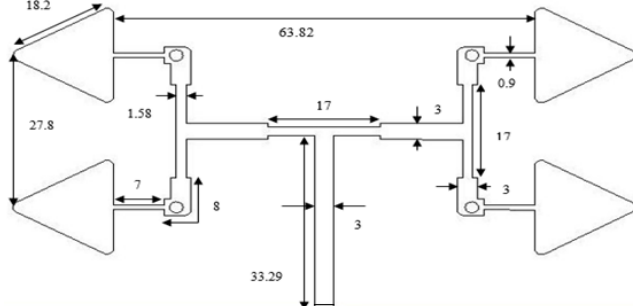
Figure 3: 2×2 Modified Triangular antenna array(All dimensions are in mm|)